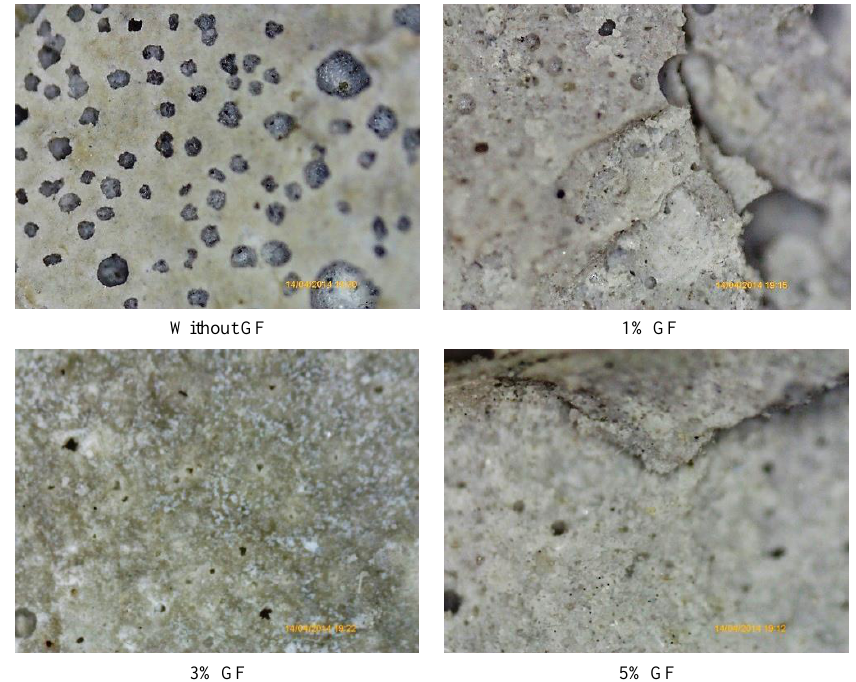
Figure 7. Visual photographs (×500) of slag-based building blocks reinforced with obtained GFs